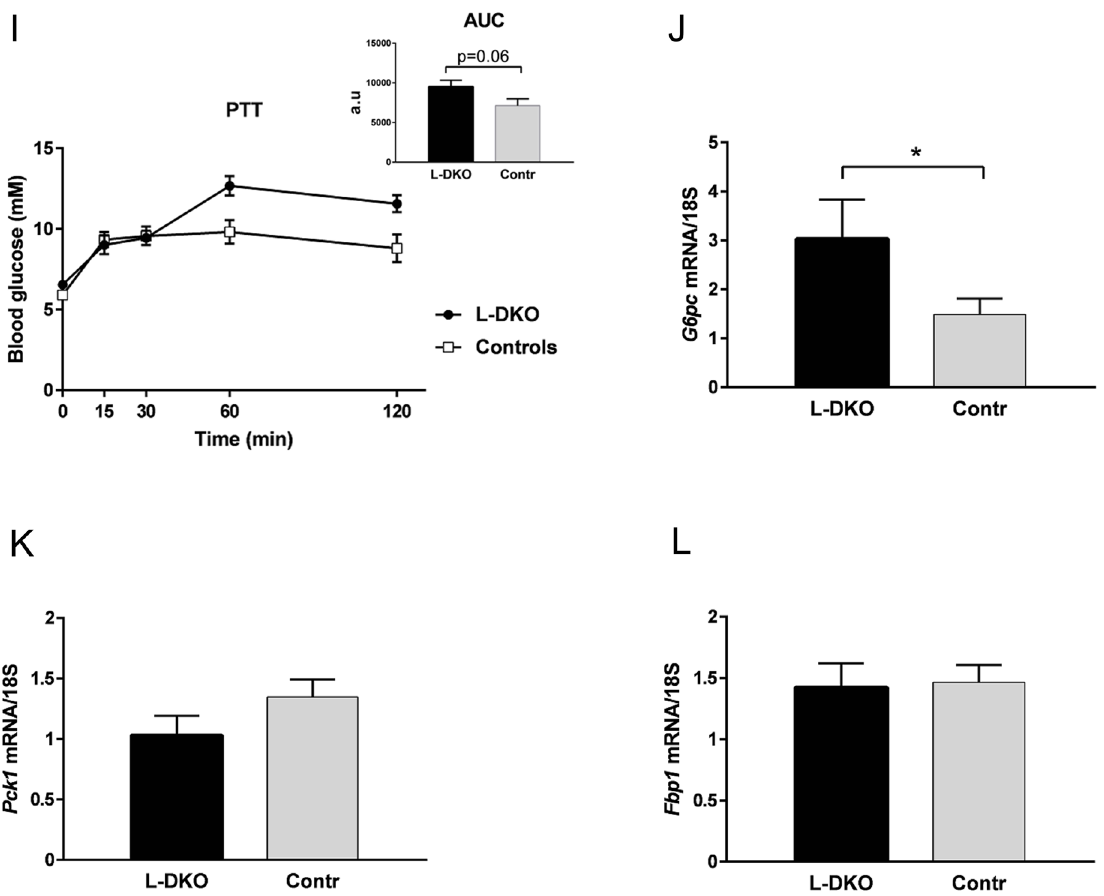
Figure 4. Glucose homeostasis. Glucose tolerance test at ( A ) 8 weeks, ( B ) 16 weeks and ( C ) 24 weeks of age; ( D ) fasting insulin levels at 10 weeks of age; ( E ) insulin tolerance test at 19 weeks of age; ( F ) fasting glucose levels; ( G ) random fed glucose levels; ( H ) fasting glucagon levels; ( I ) pyruvate tolerance test at 15 weeks of age; ( J – L ) hepatic mRNA expression of the gluconeogenic markers glucose 6-phosphatase ( G6pc ), phosphoenolpyruvate carboxykinase ( Pck1 ) or fructose 1,6-bisphosphatase ( Fbp1 ). L-DKO mice and controls were given 2 g glucose/kg body weight intraperitoneally (i.p.) for the glucose tolerance test or 1.25 U insulin/kg body weight i.p. for the insulin tolerance test or 2 g pyruvate/kg body weight i.p. for the pyruvate tolerance test. Blood glucose was measured at 0, 15, 30, 60, and 120 min. Error bars indicate SEM (n =6–12). *, p < 0.05. The insets in the glucose tolerance test graphs and the pyruvate tolerance test graph show the area under the curve (AUC) with subtracted basal glucose